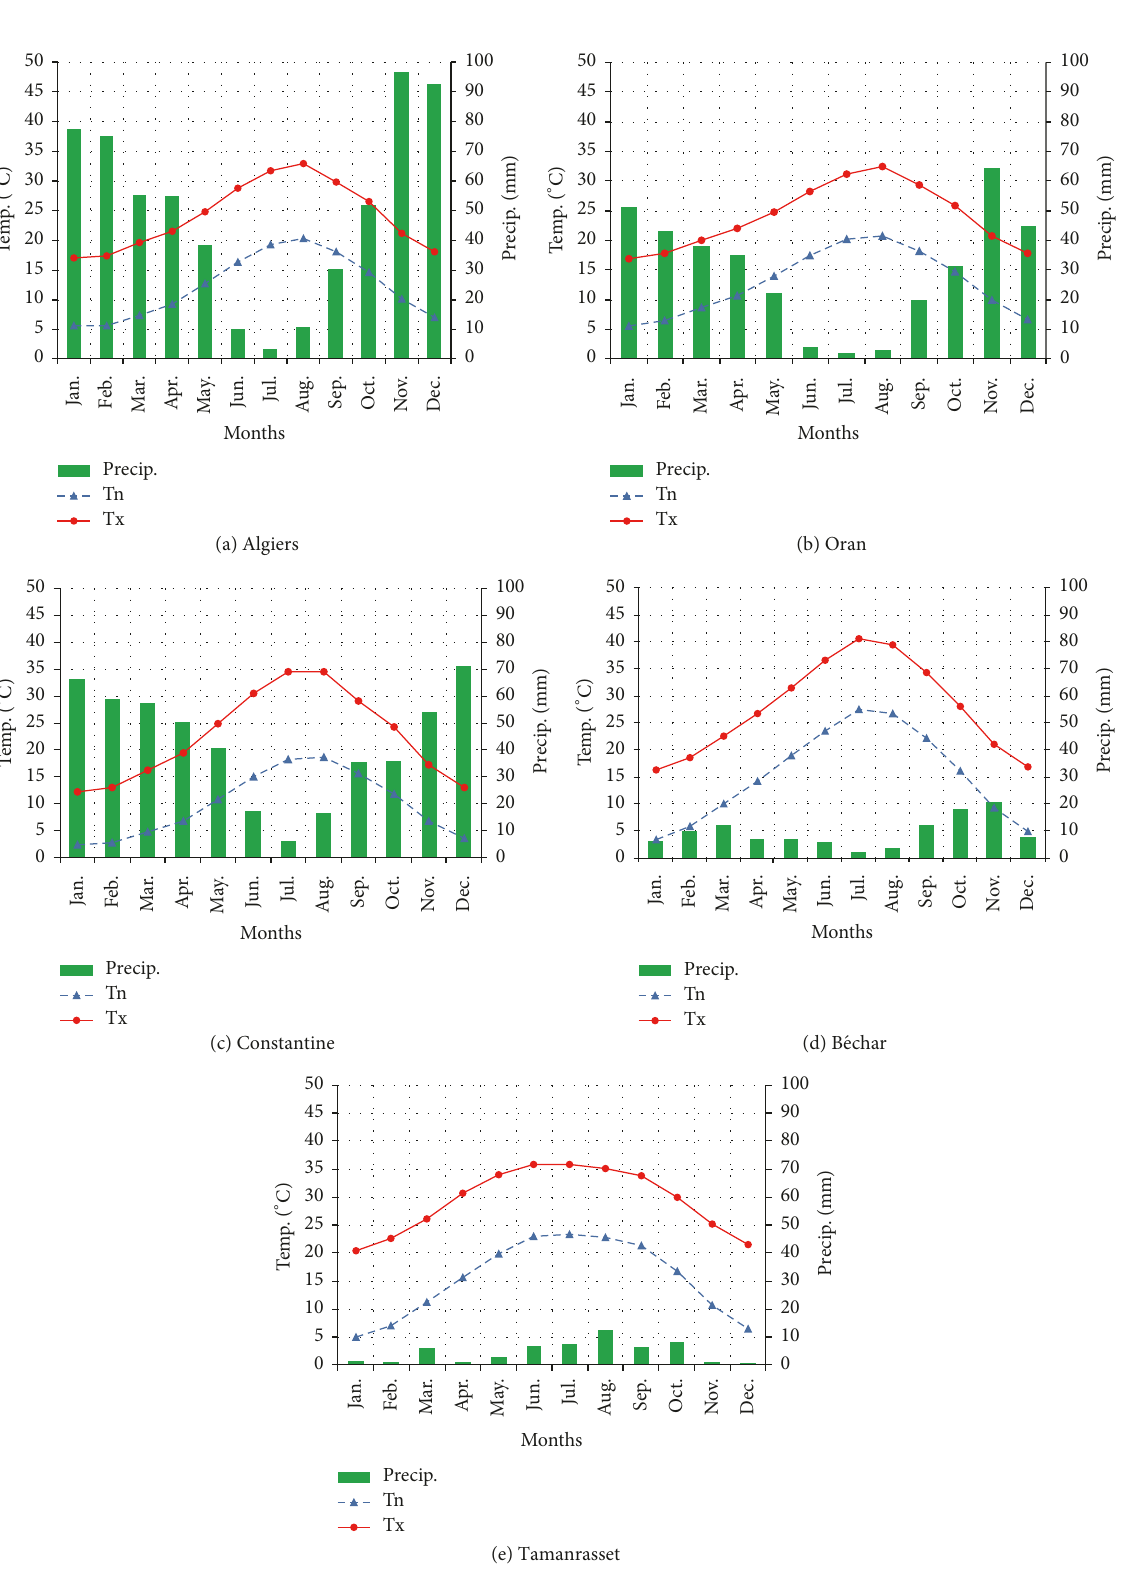
Figure 2: Climate diagram of the 5 Algerian cities for the period of 1986–2015. “Tx” is the mean monthly maximum air temperatures (red solid line); “Tn” is the mean monthly minimum air temperatures (blue dashed line); and “Precip.” is the mean monthly precipitation amount in mm (green